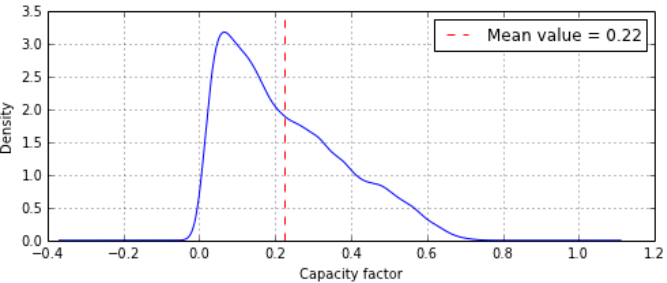
Figure A2. Autocorrelation plot for natural gas-fueled generation.